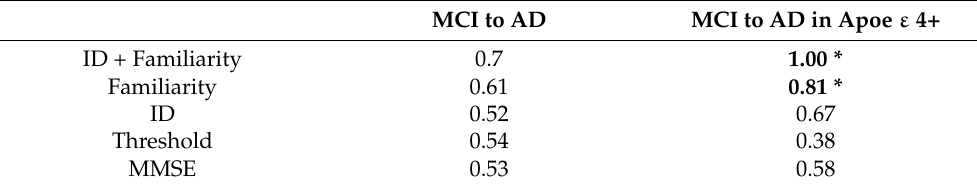
Table 4. AUC values for odor measures and MMSE: MCI converting to AD.